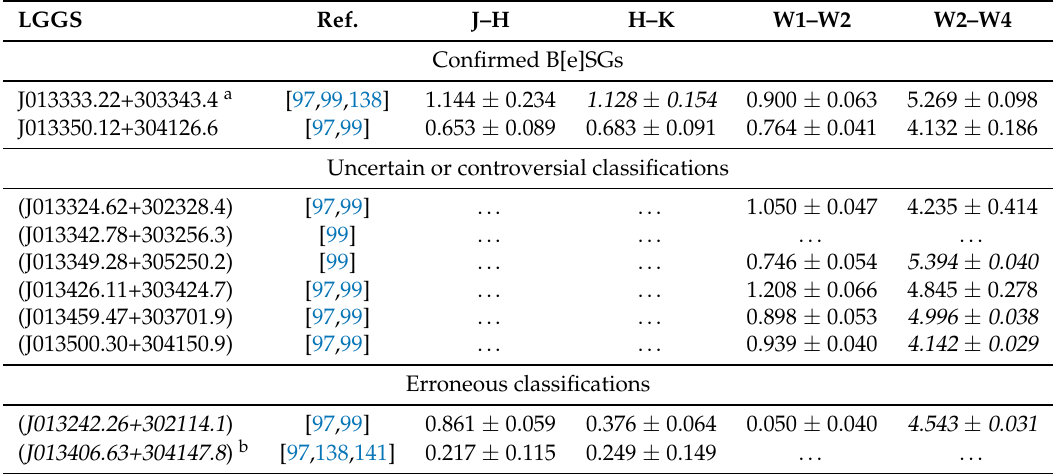
Table 7. Confirmed and candidate B[e]SGs in M33. Misclassified objects are listed at the bottom of the